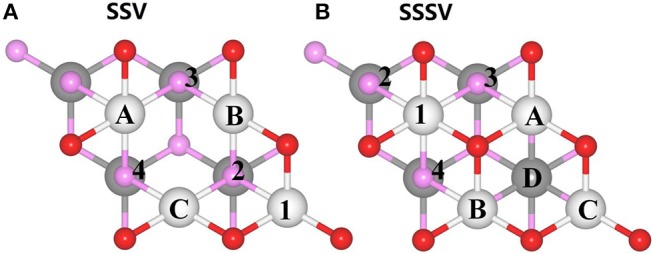
Structural model of the CeO2 (111) unit cell with 2×2 periodicity. (A) single surface vacancy, SSV, and (B) single subsurface vacancy, SSSV. The color scheme for atoms and vacancies corresponds to that used in Figure 1. The labeling scheme for the captions also corresponds to that in Figure 1. Only the five outermost atomic layers are shown for simplicity.